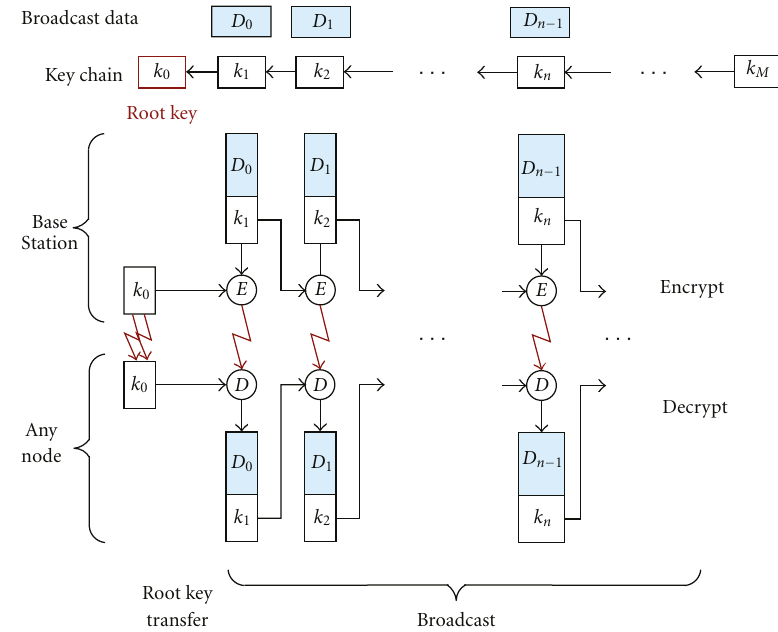
Figure 1: Key chain encryption of broadcast